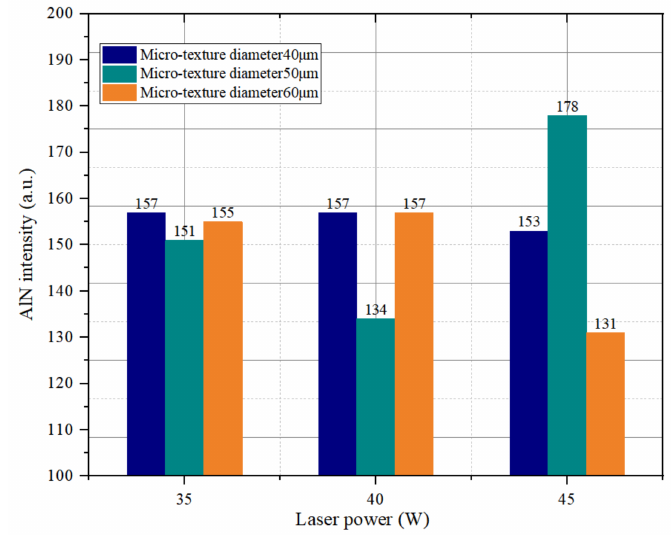
Figure 8. Binary interaction diagram.